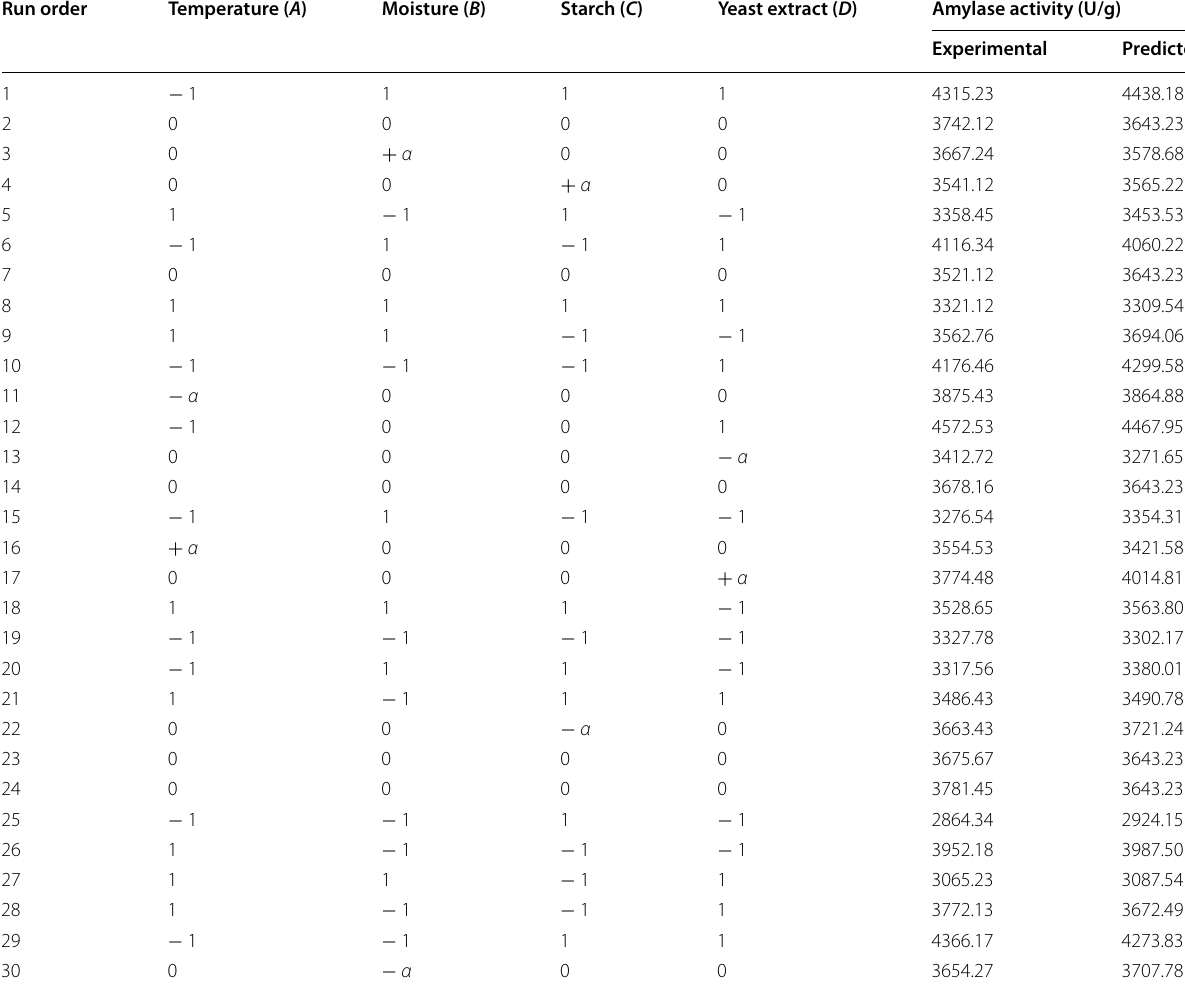
Table 5 Experimental and predicted values of response through CCD Run